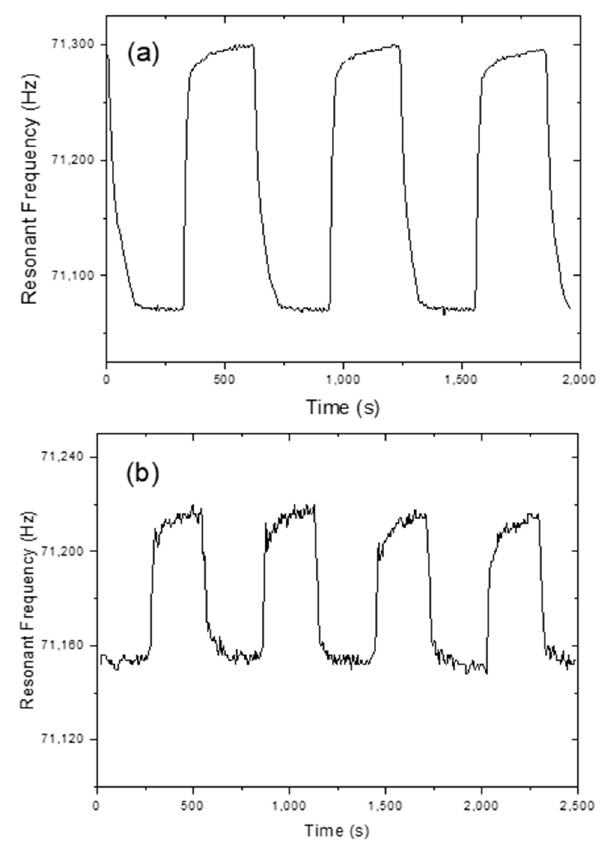
Figure 6. Frequency response of TiO 2 NT-coated MES-1, ( a ) for cycling between 5% and 95% RH, ( b ) for cycling between 50% and 75% RH.